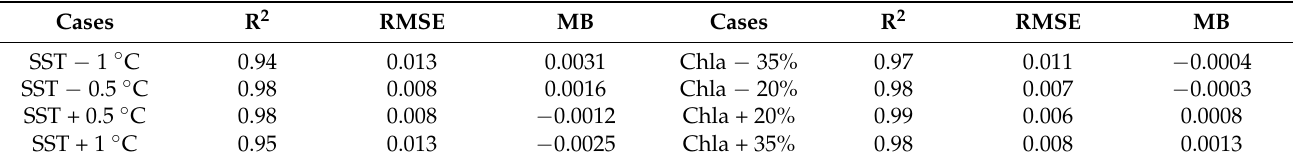
Figure 12. Sensitivity test of the pH inversion model based on the RF model. Uncertainties of ± 0.5 ◦ C and ± 1 ◦ C were added to the input parameter of SST, and uncertainties of ± 20% and ± 35% were added to the input parameter of Chla, and the stability of the output pH was compared with that of the original input. The red dotted line is 1:1 line. Table 5. Results of sensitivity analysis of pH inversion model based on the RF